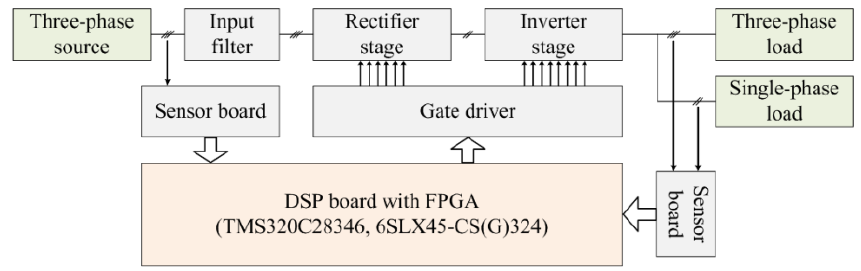
Figure 12. Experimental set: ( a ) control board; ( b ) power board of the conventional SMC; ( c ) power board of the proposed topology.